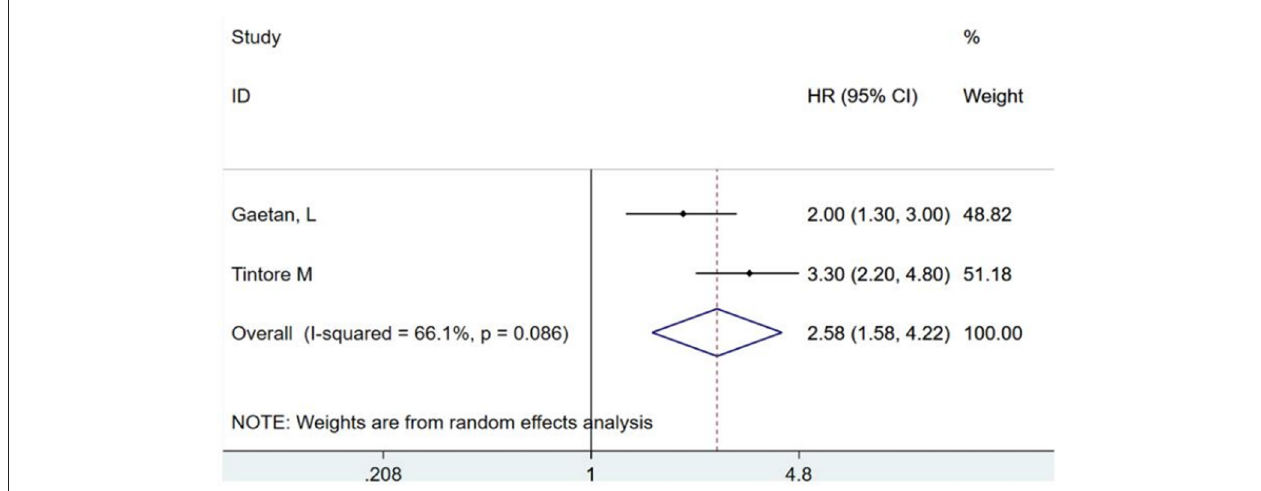
FIGURE 2 | Brainstem and cerebellar lesions predict the risk ratio of conversion of clinically isolated syndromes to clinically definite multiple sclerosis. HR, hazards ratio; CI, confidence